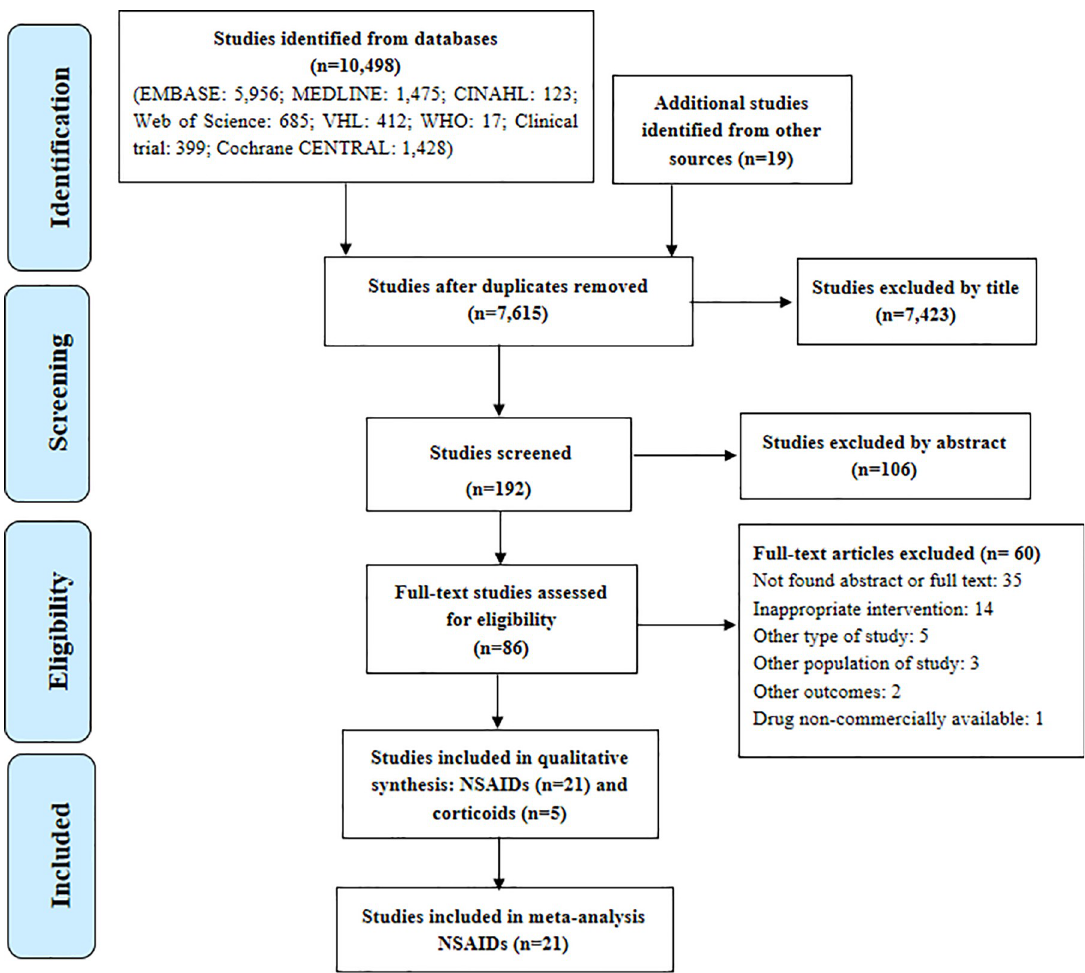
Fig 1. Study flowchart. VHL: Virtual Health Library; WHO: World Health Organization; NSAIDs: Non-steroidal anti-inflammatory drugs; corticoids drugs.